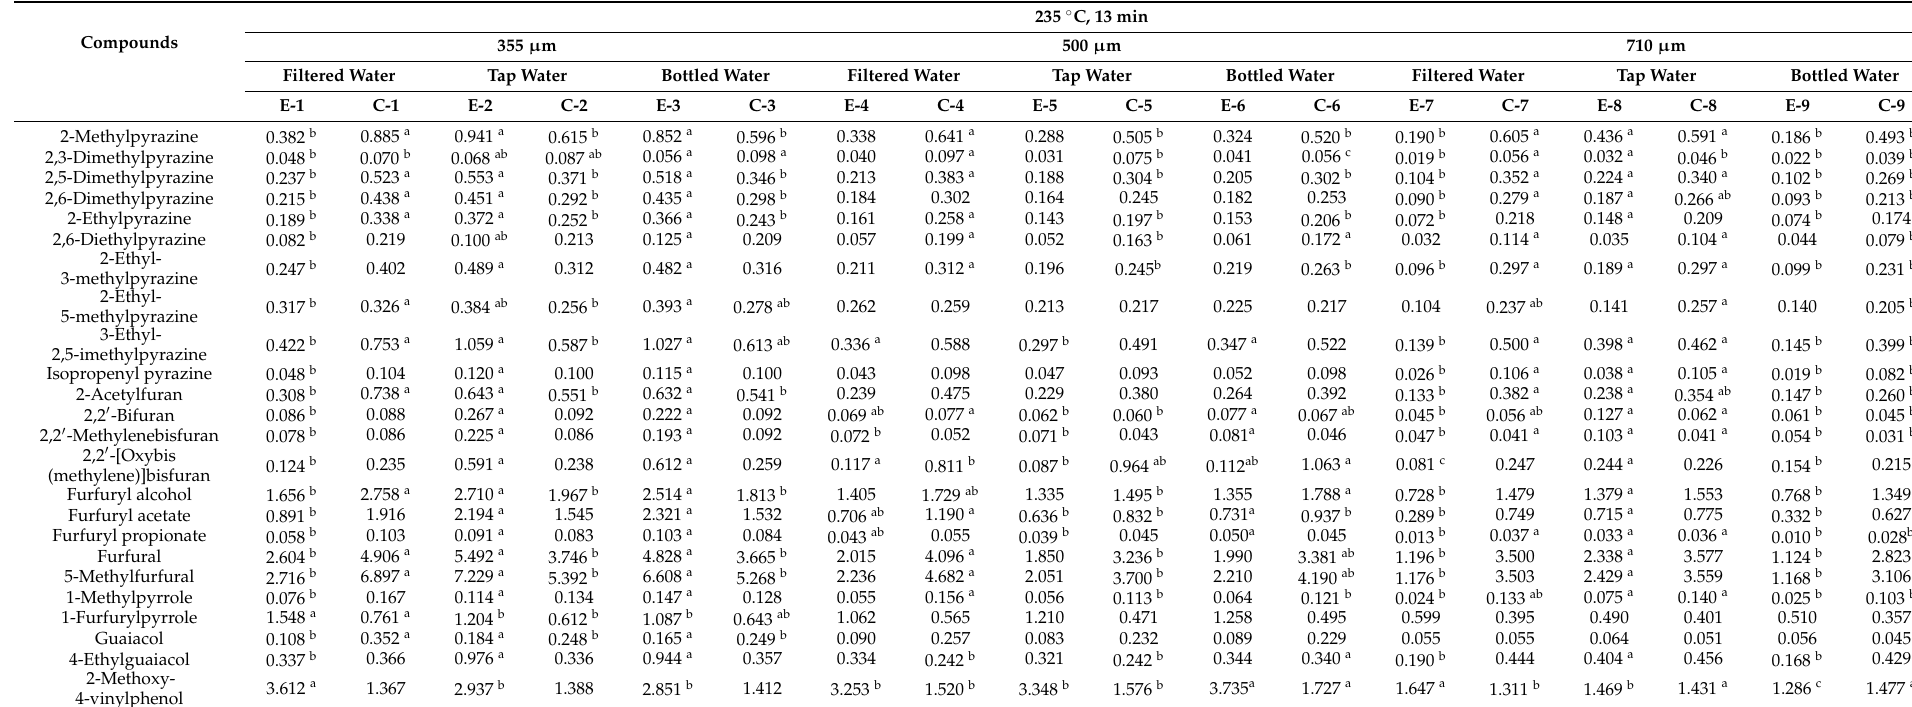
Table 2. Volatile compounds (PAR: peak area ratio) in coffee roasted at 235 ◦ C for 13 min (model E-1 to E-9 for expresso, C-1 to C-9 for cold brew). The sample number was also assigned to the particle size of grounded coffee (355 µ m: 1–3; 500 µ m: 4–6; 710 µ m: 7–9). The sample number assigned according to the size of the coffee bean was divided into three equal parts according to the type of water (filtered water: 1, 4, 7; tap water: 2, 5, 8; bottled water: 3, 6,